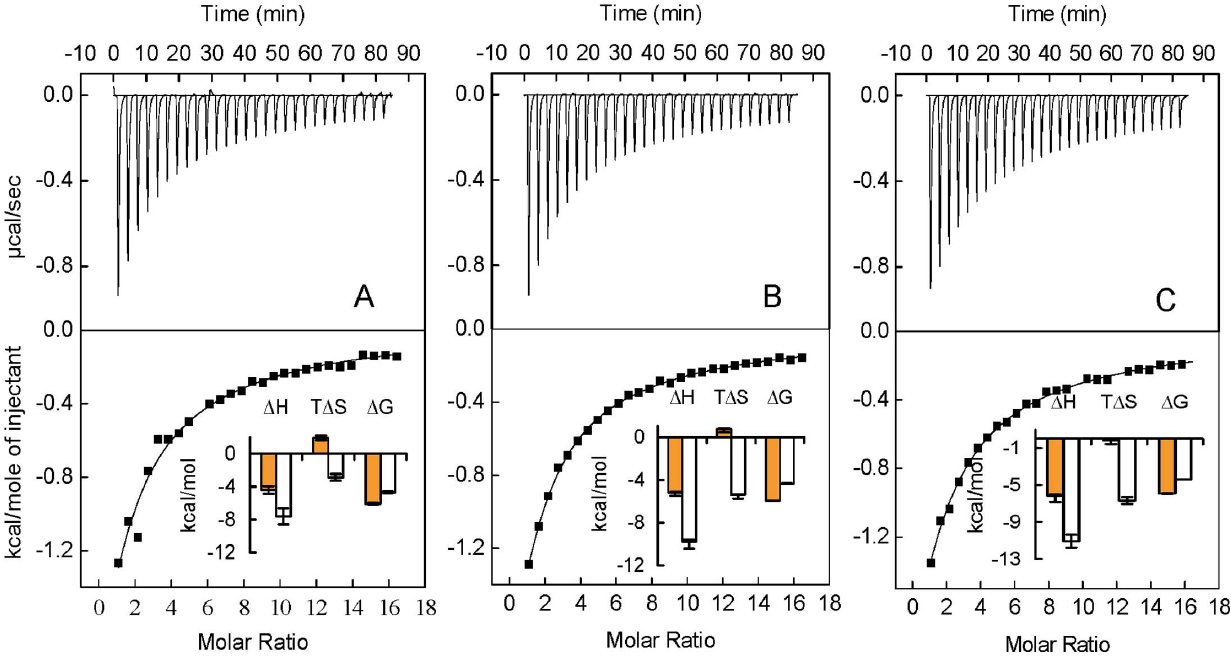
Figure 3. Isothermal titration calorimetry of HSA and HA interaction at different temperatures. A—C represent ITC profiles of HSA-HA system at 25, 30, and 37 u C, respectively. Titration of HA with (25 m M) HSA at pH 7.4 shows calorimetric response as successive injections of ligand is added to the sample cell. The solid line represent the best nonlinear least-squares fit of sequential model of two binding site. The inset of A-C represent comparative bar distribution of D H , D S and D G obtained from ITC. Each thermodynamic parameter represented by two bars, open (low affinity site) and filled (high affinity site).